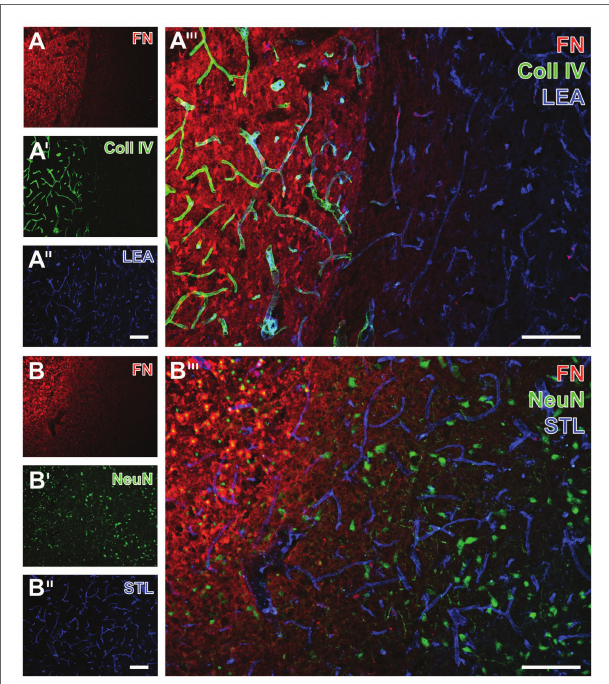
FIGURE 8 | Immunofluorescence-based visualization of microglia and astrocytes combined with fibronectin and vascular elements in rats subjected to 24 h of experimental focal cerebral ischemia. Staining of fibronectin (FN, A,B ) and lectin-based visualization of vessels using STL (A '' ,B '' ) together with microglial Iba (A ' ) and astroglial GFAP (B ' ) confirms for the rat striatum the predominantly morphological alterations of microglia and the nearly disappearing astrocytes in ischemic regions also seen in mice. FN robustly demarcates the area of ischemia (A,B) , while the merge with the staining pattern originating from microglia displays an only occasional overlap with the Iba signal (arrow in A ''' ). In contrast, STL appears evenly distributed in differently affected tissue as visualized by merging the staining patterns (A ''' ,B ''' ) . Scale bars: in A ''' and B ''' = 100 μ m, in A '' (also valid for A and A ' ) and B '' (also valid for B and B ' ) = 100 μ